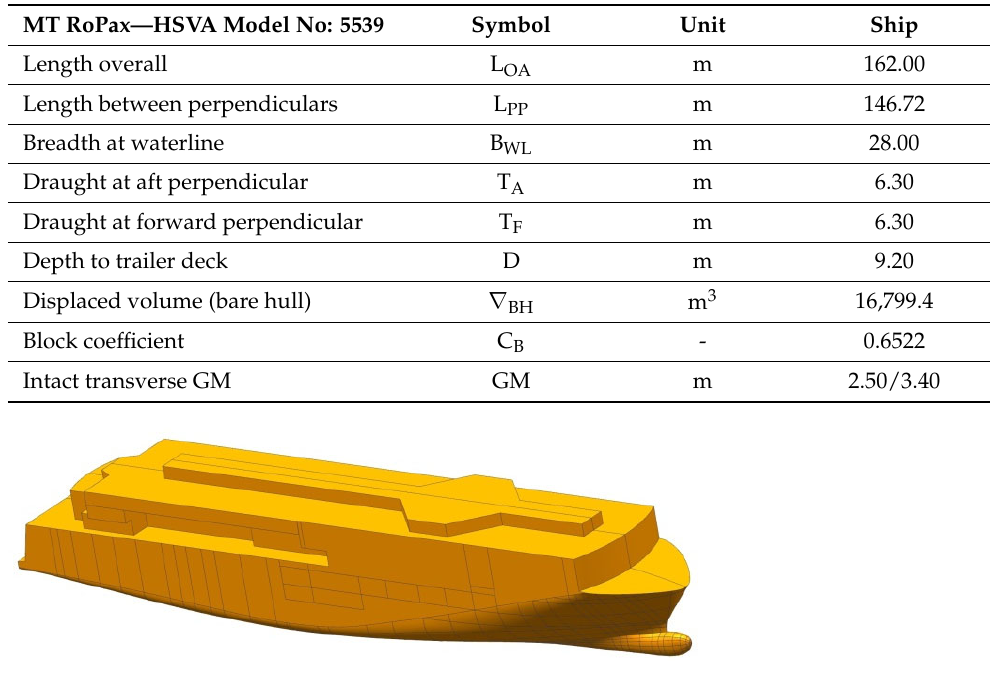
Figure 1. CAD model of the MT RoPax used in the numerical simulations of flooding mitigation. Table 1. Main data of the vessel in intact (test) condition.